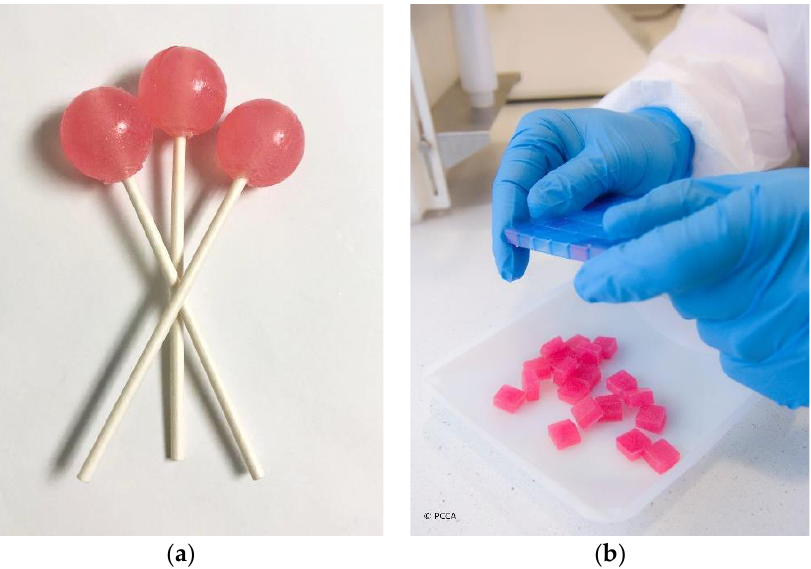
Figure 1. Child-friendly dosage forms: ( a ) medicated lollipops; ( b ) medicated lozenges (troches) (courtesy of PCCA, 2021).